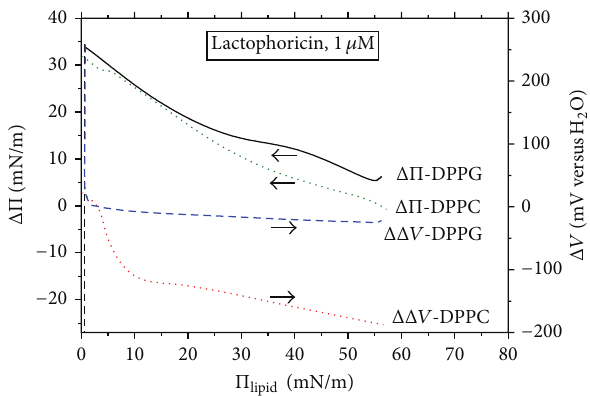
Figure 3: Effects of penetration of lactophoricin-I (N-23-T) into DPPC and DPPG monolayers on surface pressure (Π) and electric surface potential ( Δ𝑉 ); the ΔΠ and the ΔΔ𝑉 values calculated as difference in the Π and the Δ𝑉 ordinate of the isotherms registered on lactophoricin-I (N-23-T) solution (1 𝜇 M) and the pure water subphase (cf. Figures 1(a) and 1(b))—at identical cross-sectional areas ( 𝐴 ) per the phospholipid molecule, are plotted as a function of surface pressure of the pure phospholipid monolayer, Π